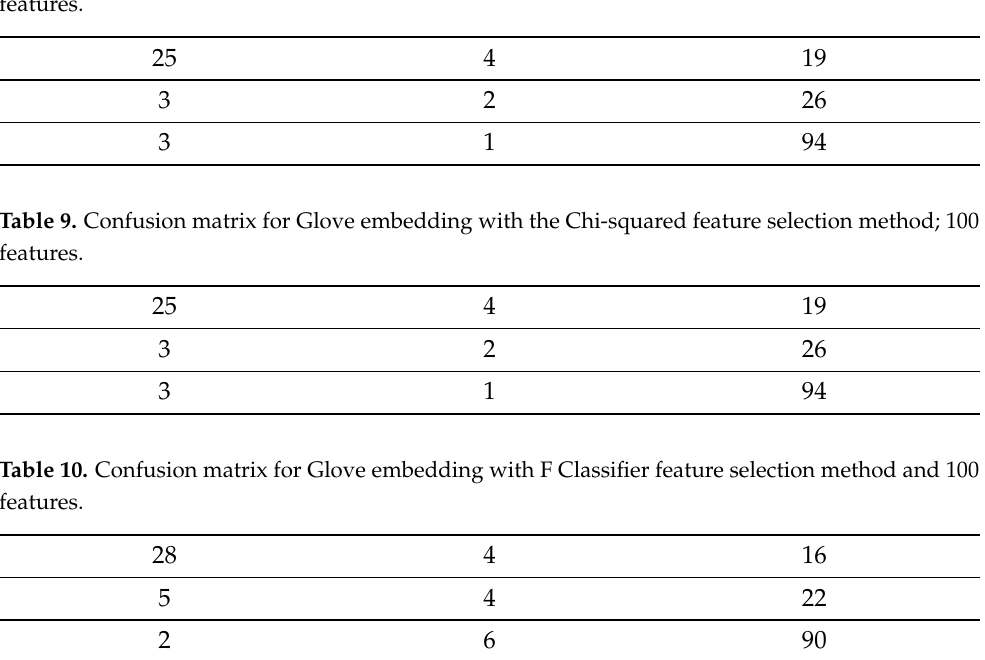
Table 8. Confusion matrix for Glove embedding with the RFE(RF) feature selection method; 100 features.